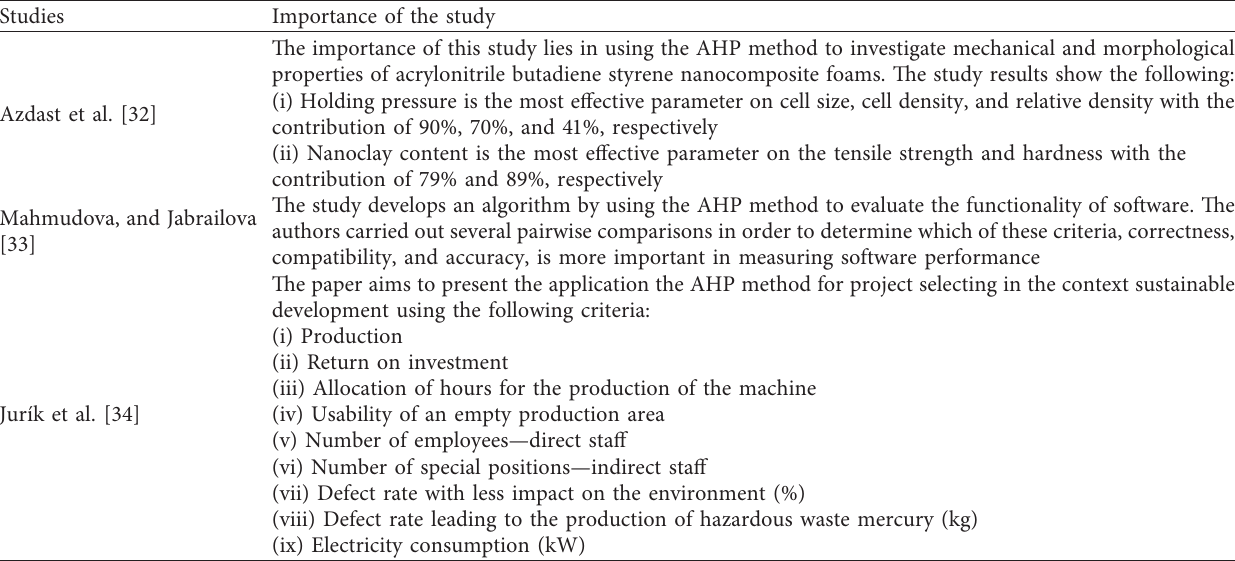
Table 5: Examples of AHP uses in different multicriteria decision-making